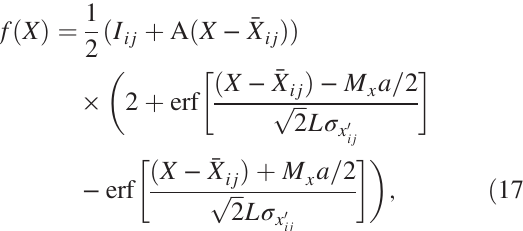
FIG. 1. Top: intensity plot of a sample image at the screen, generated from the output of a simulation (details in Sec. III) of an electron beam masked with a TEM300 grid. Axis labels of the image are in pixels and the pixel size is 15 μ m. Middle: sheared image with horizontal and vertical lines showing detected minima of the projections onto the axis. These projections are also shown as red lines on the image. Bottom: screen intensity profile showing points where the fits are done.